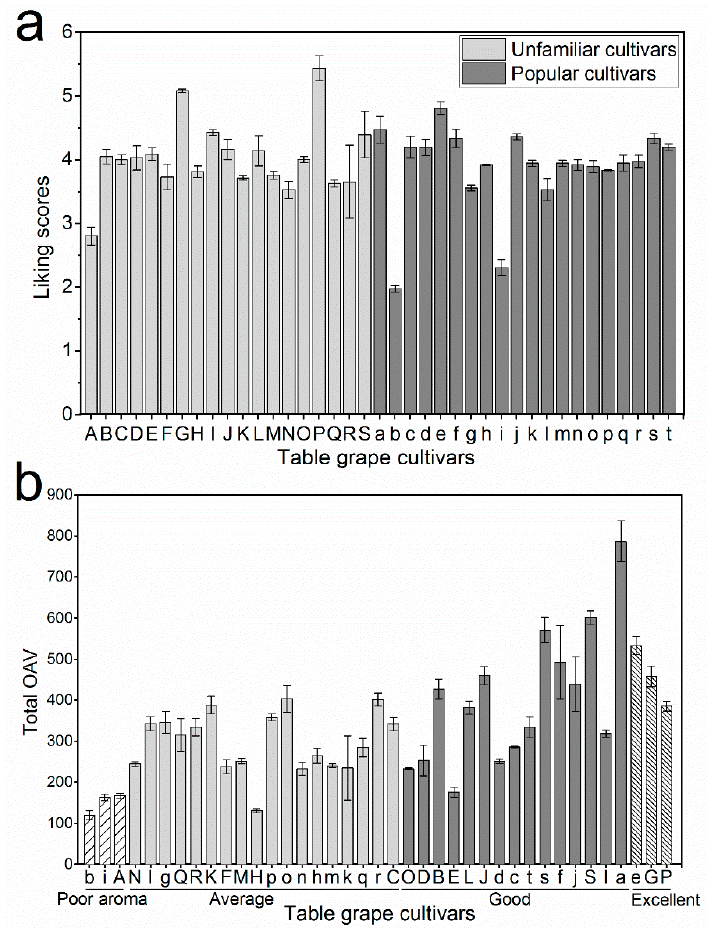
Figure 5. The predicted aroma consumer liking and aroma intensity (OAVs) of all table grapes. ( a ) The predicted aroma consumer-liking scores of unfamiliar and popular cultivars. The scores of unfamiliar cultivars were obtained by orthogonal partial least square (OPLS) regression prediction, whereas the scores for popular cultivars were obtained from sensory analysis in our previous study [10]. Lower-case